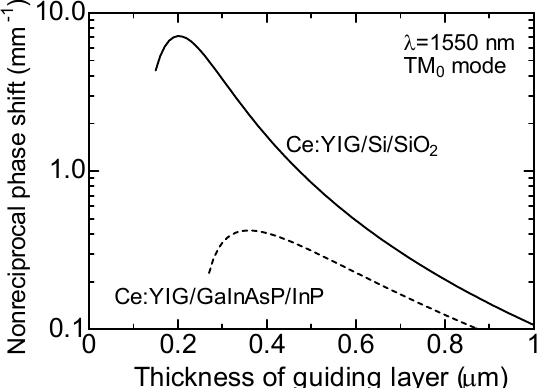
Figure 5. Calculated nonreciprocal phase shift of TM and Ce:YIG/GaInAsP/InP slab waveguides as a function of the thickness of guiding layer at a wavelength of 1,550 nm [38]. The specific Faraday rotation of Ce:YIG is assumed to be  = − F